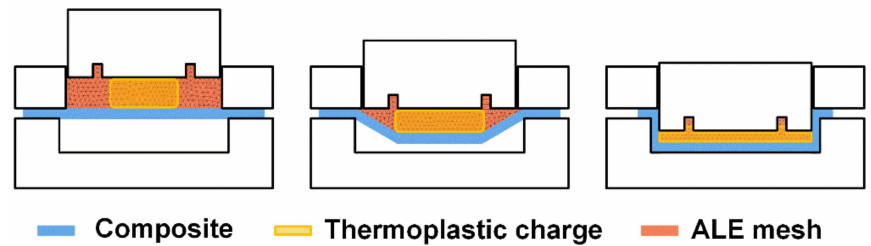
Figure 2. The ALE description for compression-stamping